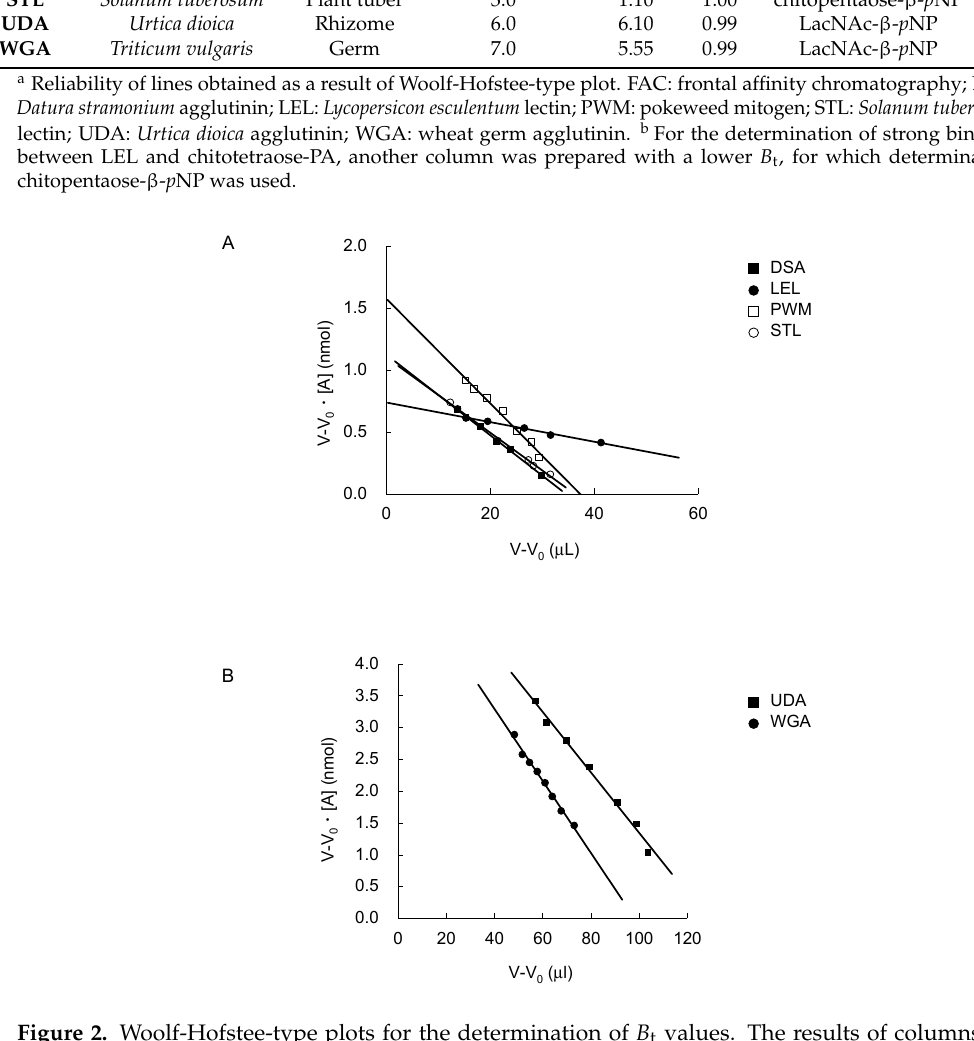
Figure 2. Woolf-Hofstee-type plots for the determination of B t values. The results of columns for DSA (closed squares), LEL (closed circles), PWM (open squares) and STL (open circles), and those for UDA (closed squares) and WGA (closed circles) are shown in panels A and B, respectively. For concentration-dependent analysis, appropriate p NP-sugars were used: LacNAc- β - p NP for LEL, UDA, and WGA, chitotetraose- β - p NP for DSA, and chitopentaose- β - p NP for PWM and STL columns. Plots were made by using data, V − V 0 vs. ( V − V 0 ) [A] 0 , obtained in the concentration range 2–60 µ M. For details, see text.